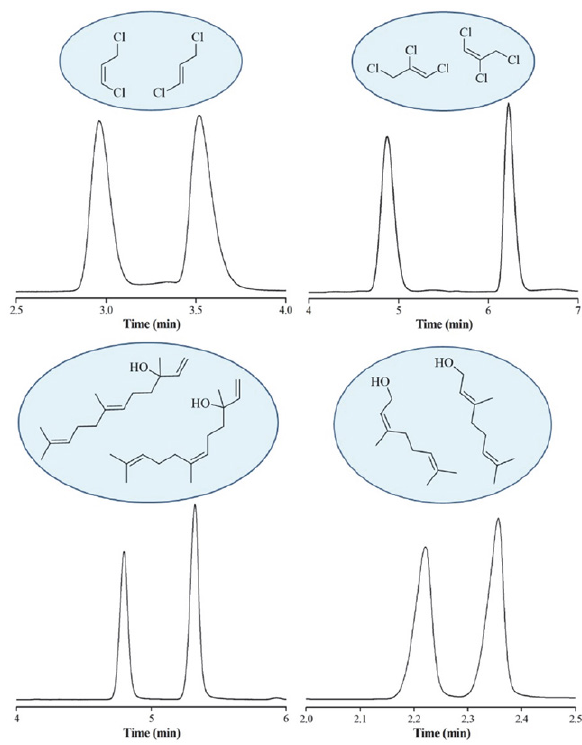
Fig. 4. GC separations of cis -/ trans - isomers. Temperature process: 40 °C (keep 1 min) up to 160 °C (keep 5 min) at 10 °C/min and gas flow rate at 0.6